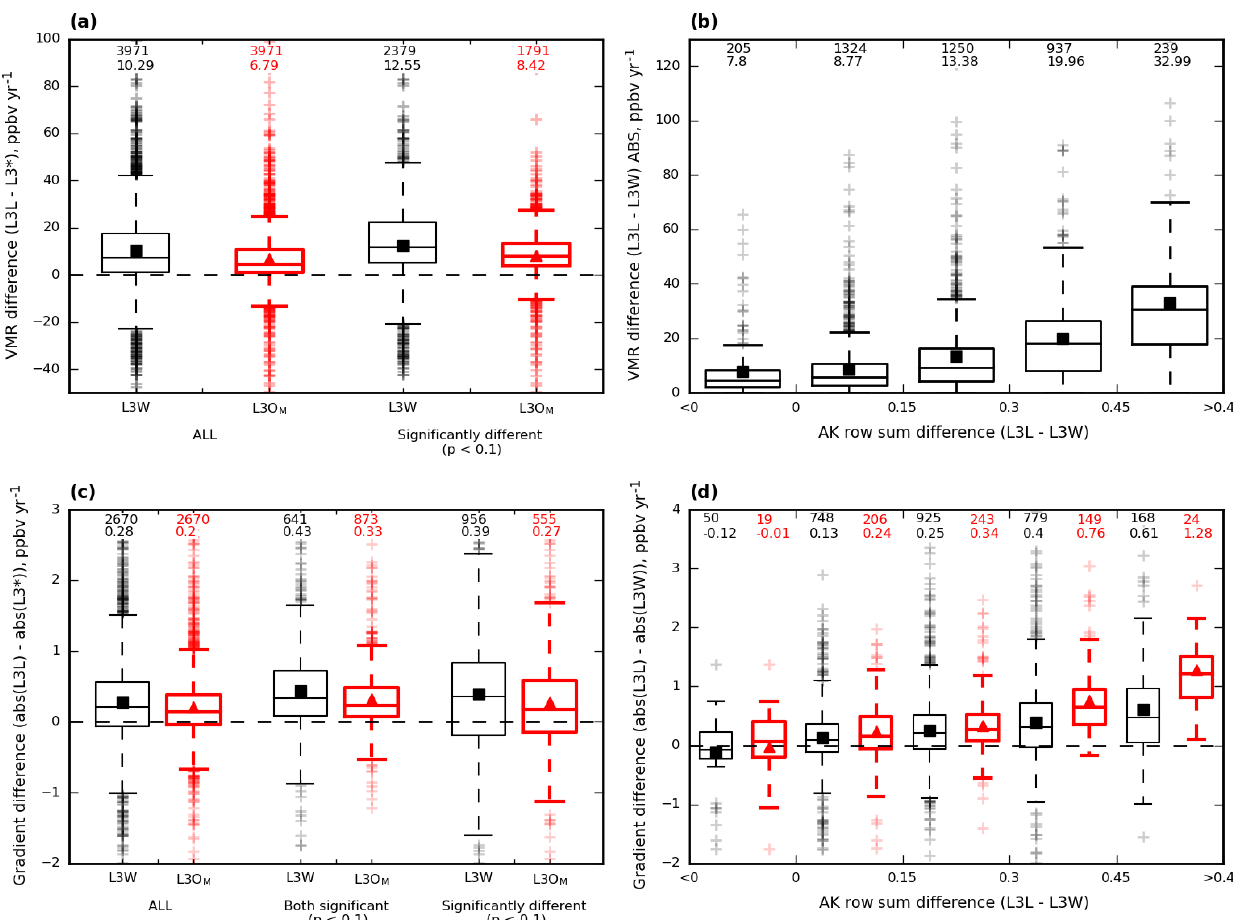
Figure 5. Boxplots showing how mean VMRs and trends from WLS analysis compare for coastal L3 grid boxes, calculated from matched retrievals within these grid boxes. Matched means that only days when both L3L and L3W are present and the L3O surface index is mixed are used to create the mean values analysed. Mean values are represented by filled squares/triangles, and values above the boxplots correspond to the number of grid boxes with data for that boxplot and the mean value, respectively. (a) Mean VMR differences for L3W (black, mean values represented by filled squares) and L3O M (red, thicker lines, mean values represented by filled triangles) compared to L3L (L3L − L3* in both cases). Shown are the differences for all coastal grid boxes and for only those grid boxes where the difference is significant ( p < 0.1), determined using a two-tailed t test. (b) Absolute mean VMR differences (absolute retrieved VMR difference values are shown in (b) for clarity, since L3L − L3W can be either positive or negative depending on whether a priori VMRs used in the retrieval are greater or less than the true VMR being retrieved, which complicates the analysis; the corresponding plot with raw values (i.e. not discarding the ± sign) is included in the Supplement however, and the same conclusions can be drawn based on this figure (Sect. S5)) between L3L and L3W, stratified according to the corresponding AK row sum difference (L3L − L3W in both cases). (c) Absolute differences in gradients (for clarity, differences between the absolute trend values (i.e. ignoring the ± sign of the trend) are presented, since this shows the degree of difference in the trend magnitude, irrespective of trend direction; a positive trend difference in this case signifies a stronger (faster) trend in L3L than in L3* c or L3W d .) detected using WLS regression analysis for L3W (black, mean values represented by filled squares) and L3O M (red, thicker lines, mean values represented by filled triangles), compared to L3L (L3L − L3* in both cases). Shown are differences for all coastal grid boxes where WLS analysis could be performed, for grid boxes where both trends compared are significantly different to zero ( p < 0.1), and for grid boxes where the trend difference is significant ( p < 0.1). (d) Absolute differences in gradients (for clarity, differences between the absolute trend values (i.e. ignoring the ± sign of the trend) are presented, since this shows the degree of difference in the trend magnitude, irrespective of trend direction; a positive trend difference in this case signifies a stronger (faster) trend in L3L than L3* c or L3W d .) detected using WLS regression analysis between L3L and L3W, stratified according to the corresponding AK row sum difference (L3L − L3W in both cases). Shown are the differences for all coastal grid boxes where WLS could be performed (black, mean values represented by filled squares) and for only those grid boxes where the detected trend is significant ( p < 0.1) in both L3L and L3W (red, thicker lines, mean values represented by filled